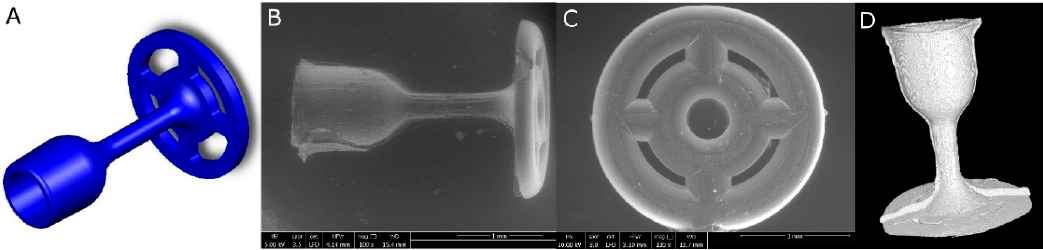
Figure 4. Middle ear prosthesis, ( A ) 3D model, ( B , C ) SEM images showing the implant from different sides, ( D ) prosthesis 3D reconstruction after micro-CT scanning.